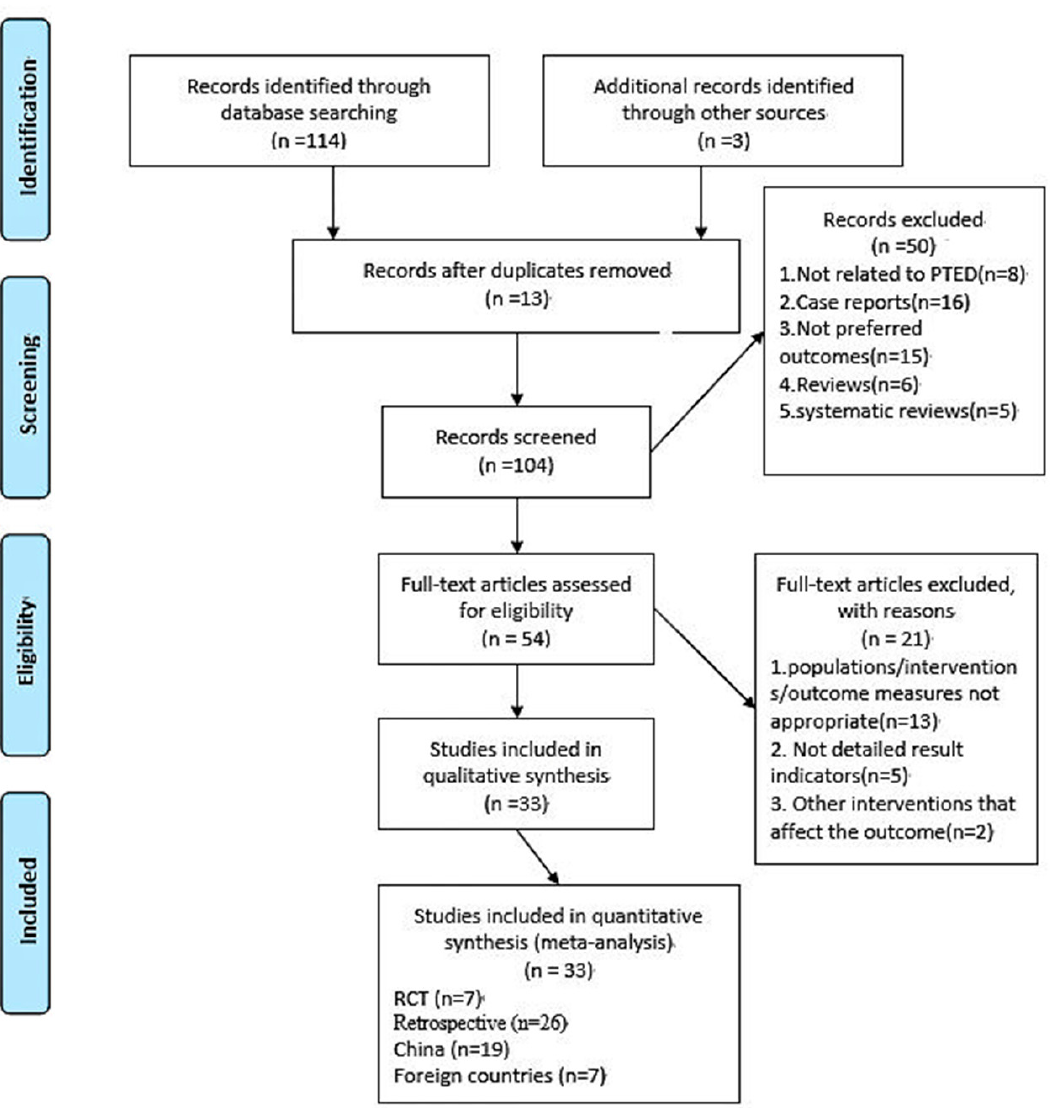
Figure 1. Flow chart of study selection.